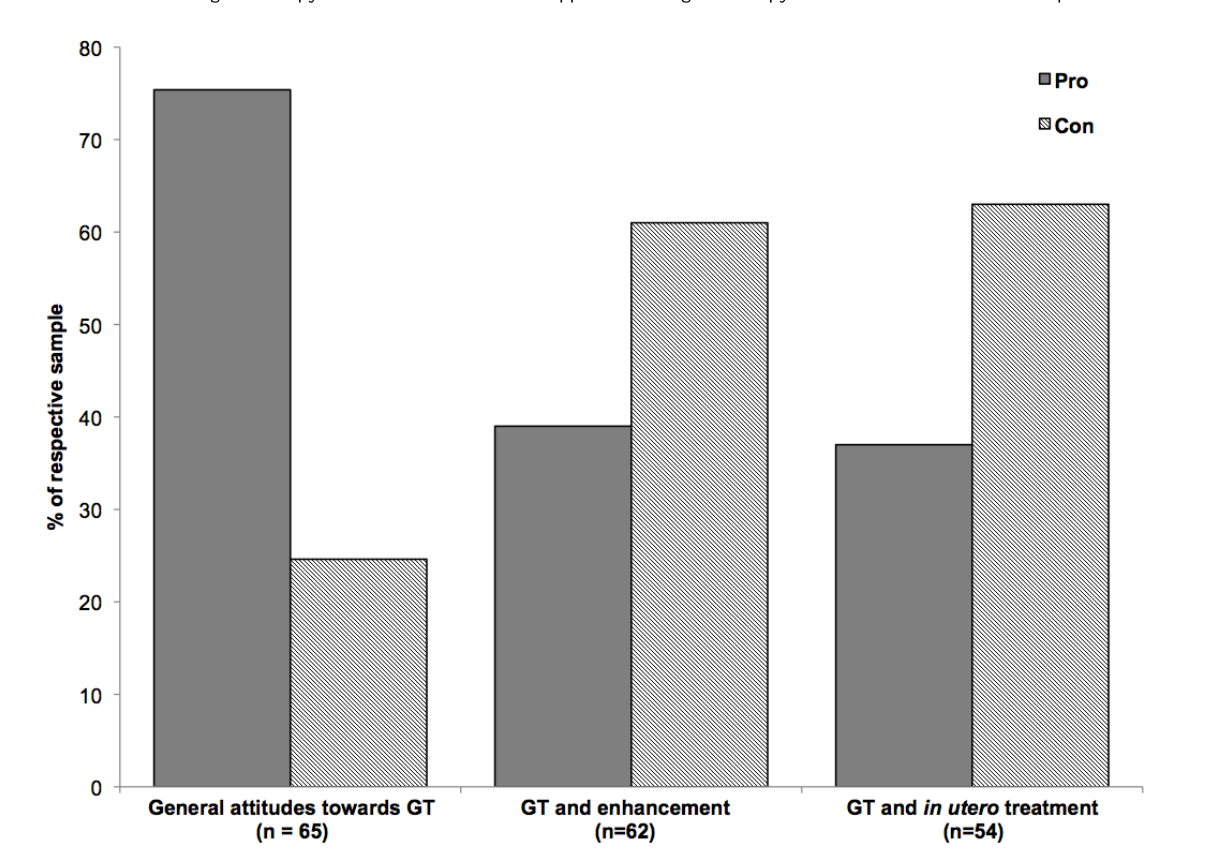
Figure 3. Attitudes towards gene therapy. General attitudes towards applications of gene therapy encountered in the answer